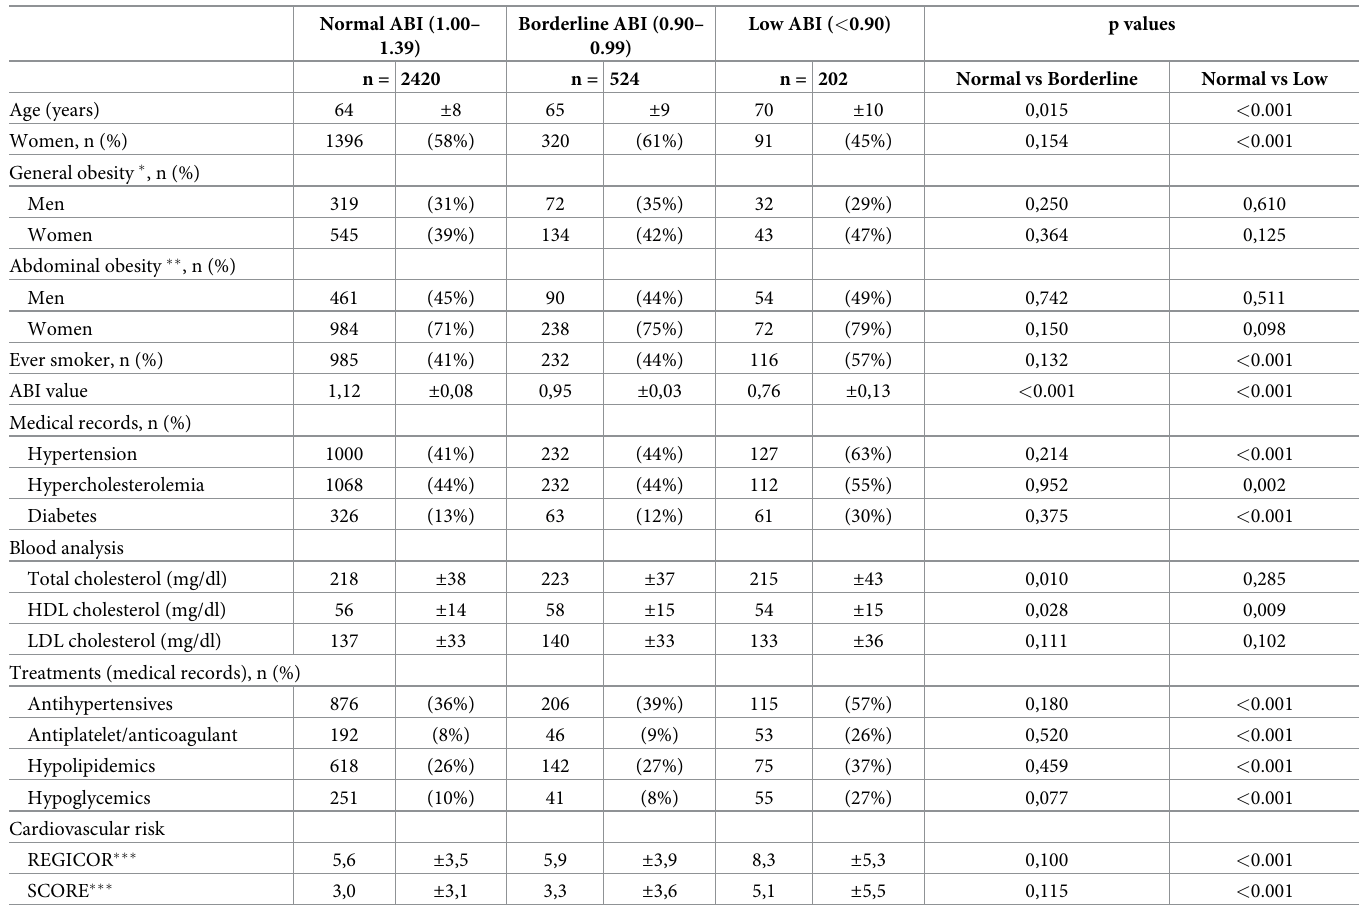
Table 1. Baseline characteristics of the patients according to ABI